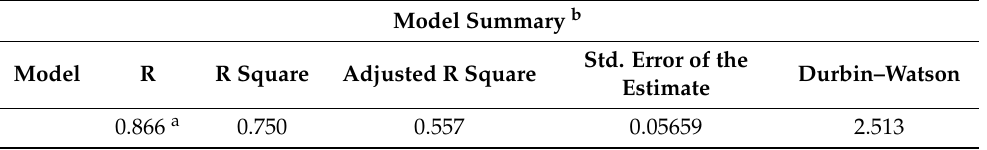
Table 9. Model summary of the regression analysis (2015).